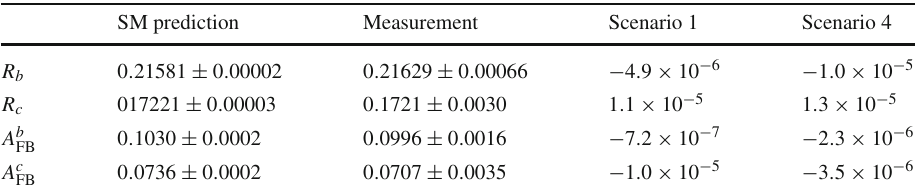
Table 16 SM predictions and experimental values of selected Z -pole observables, as well as Z − Z (cid:2) mixing contributions arising in scenarios 1 and 4 (see the